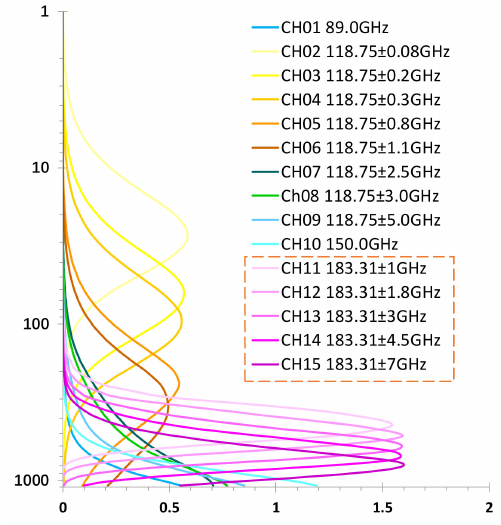
Figure 2. The weighting functions for MWHS channels. Table 2. Water vapor channels information of MWHS.